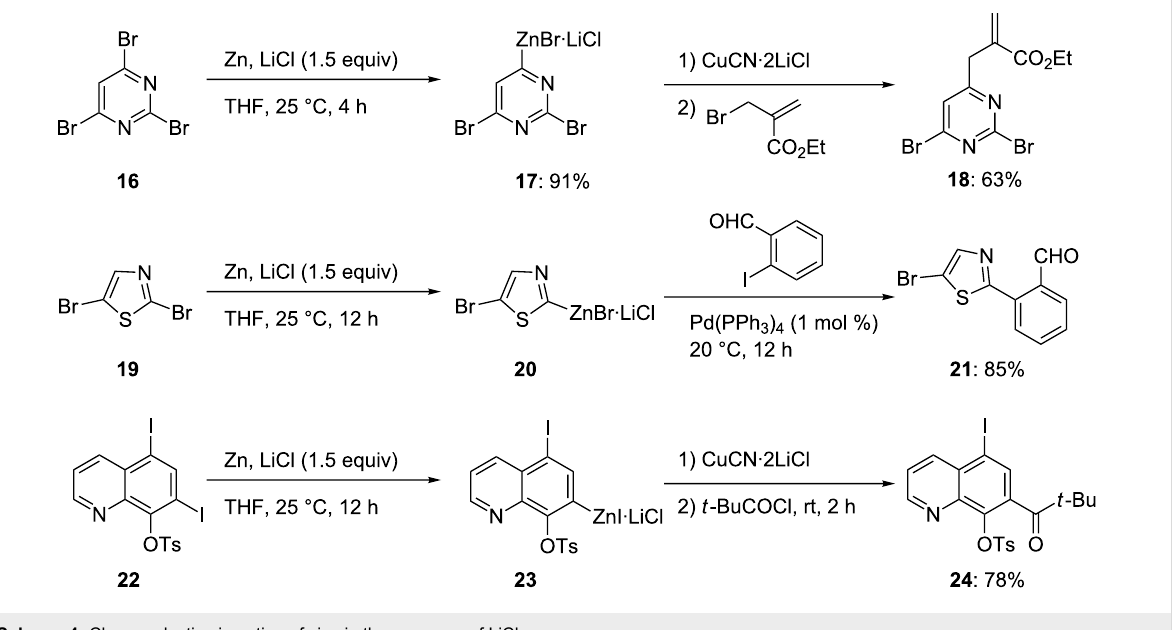
Scheme 4: Chemoselective insertion of zinc in the presence of